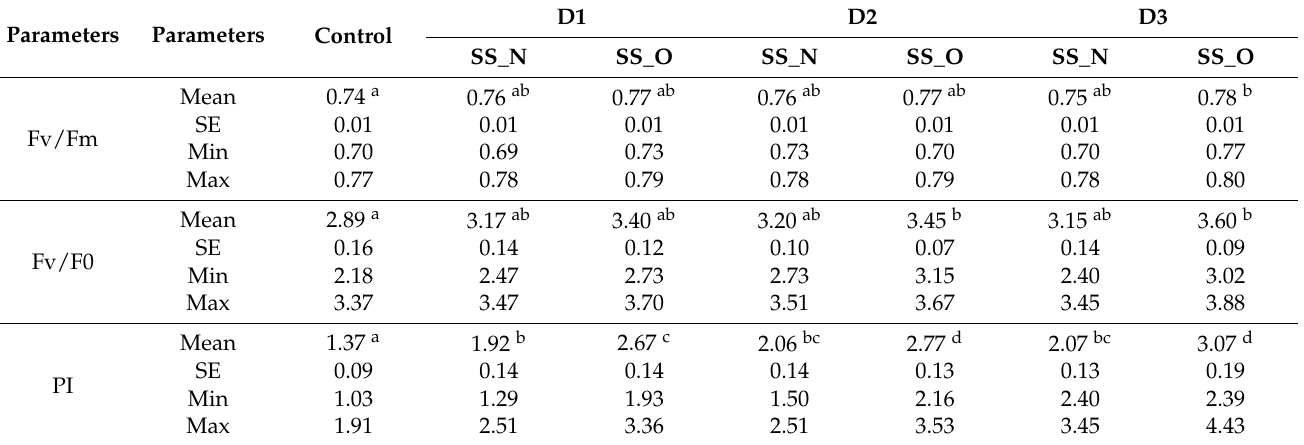
Table 4. Chlorophyll fluorescence parameters in maize leaves depending on the sewage sludge dose and type. Mean values (n = 9) ± standard error. Identical superscripts denote no significant ( p > 0.05) differences between the experimental variants according to the post hoc Tukey HSD test .